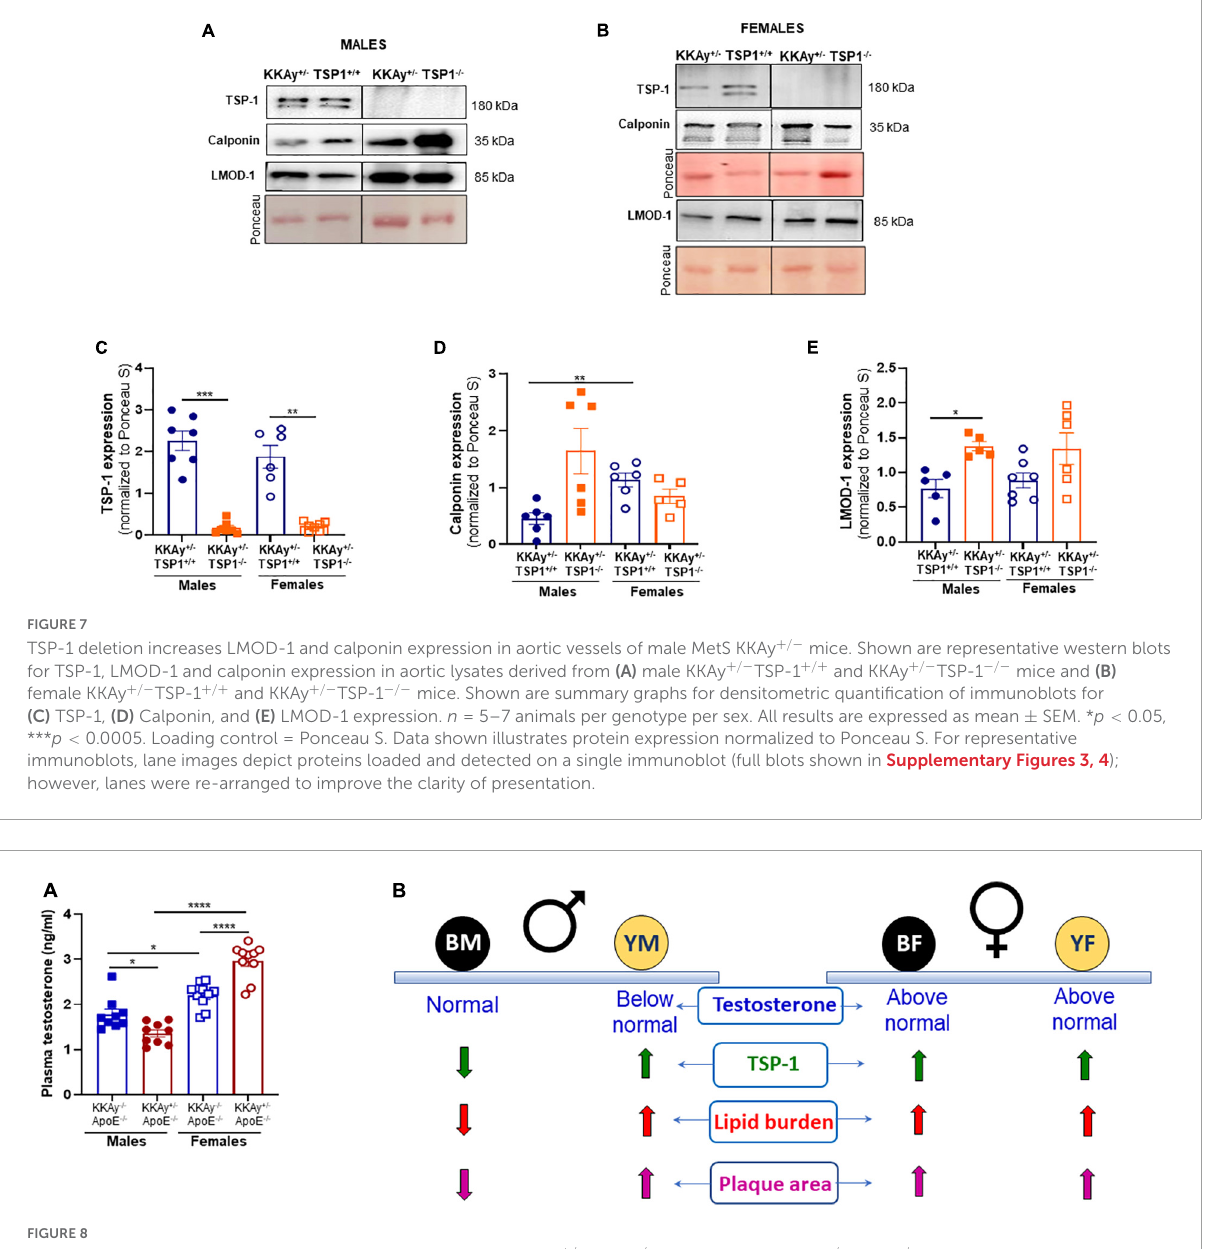
wall. TSP-1 is a multifunctional protein with cell- and